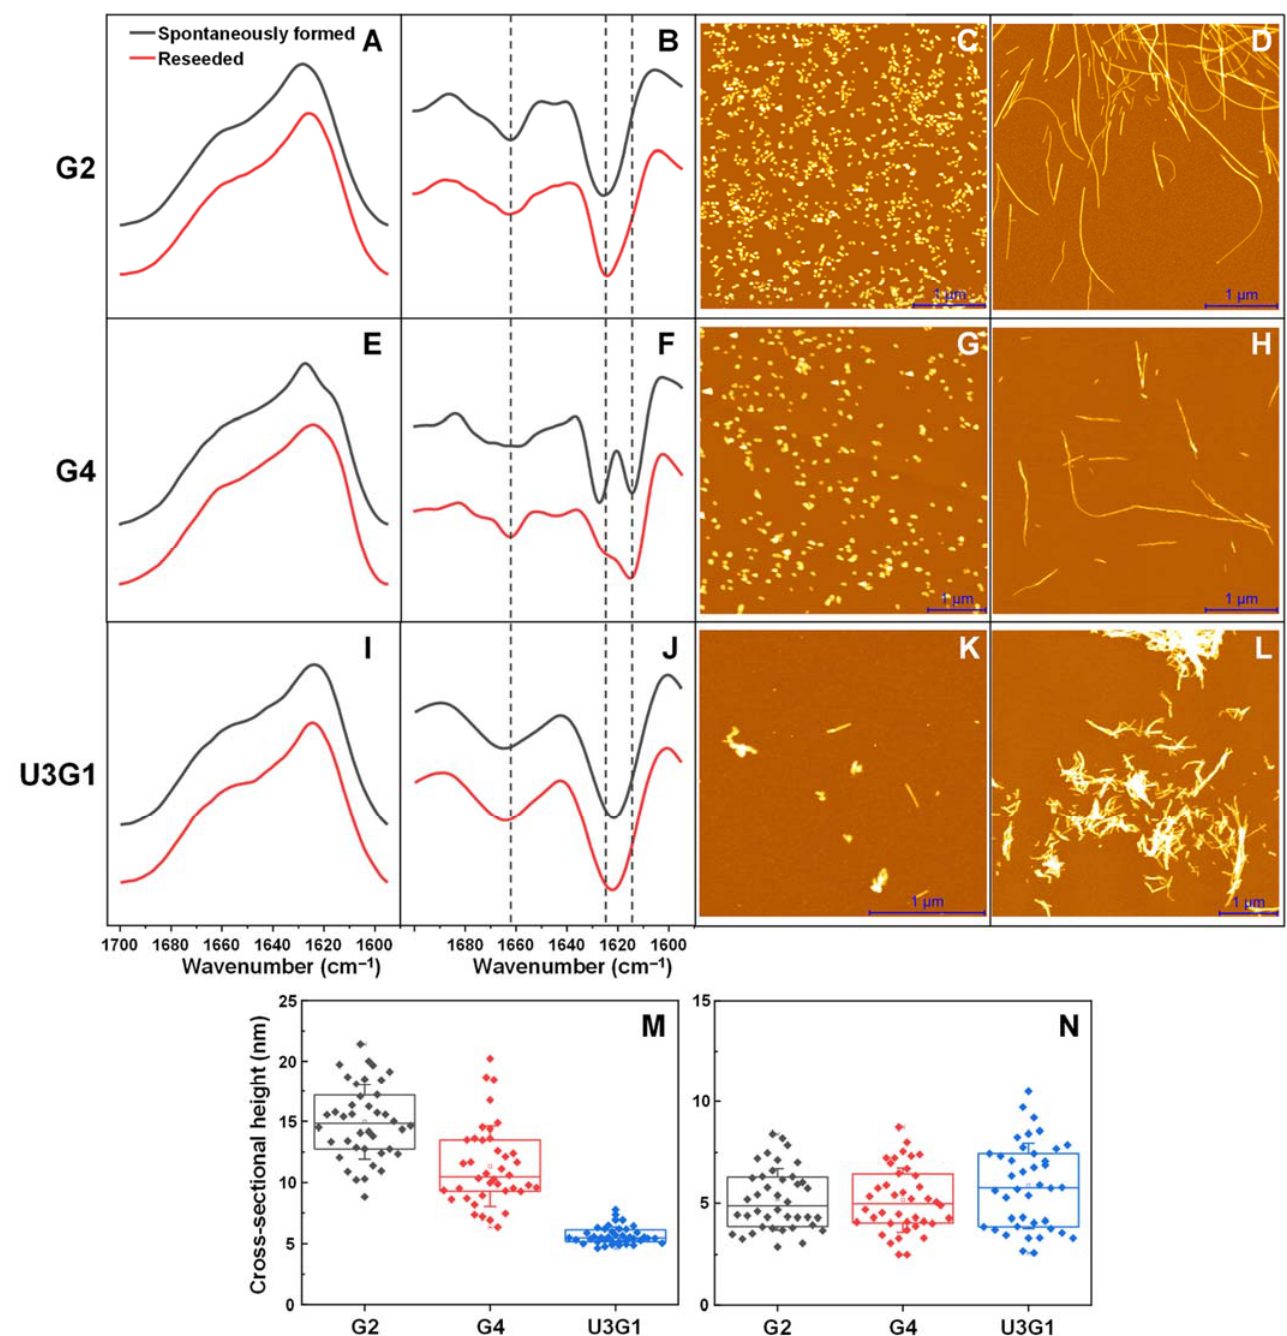
Figure 1. FTIR spectra and AFM images of spontaneously formed and reseeded MoPrP(89-230) fibrils. FTIR spectra and their second derivatives of G2 ( A , B ), G4 ( E , F ) and U3G1 ( I , J ) condition fibrils. AFM images of spontaneously formed ( C , G , K ) and reseeded ( D , H , L ) G2, G4 and U3G1 condition fibrils respectively. Cross-sectional heights of spontaneously formed ( M ) and reseeded fibrils ( N ).